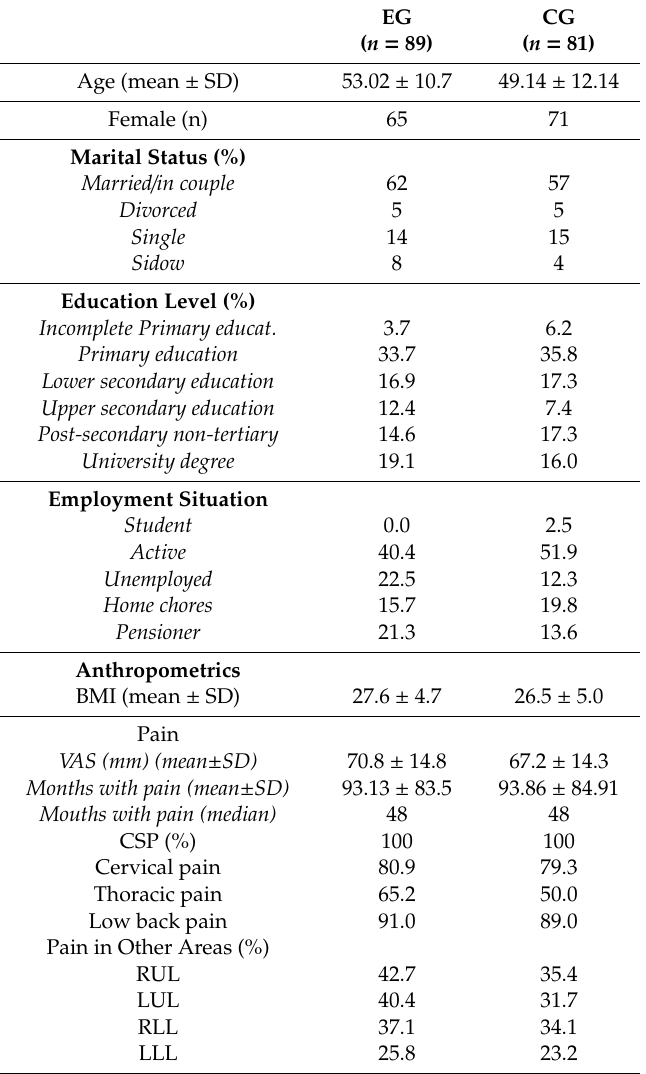
Table 1. Characteristics of the recruited